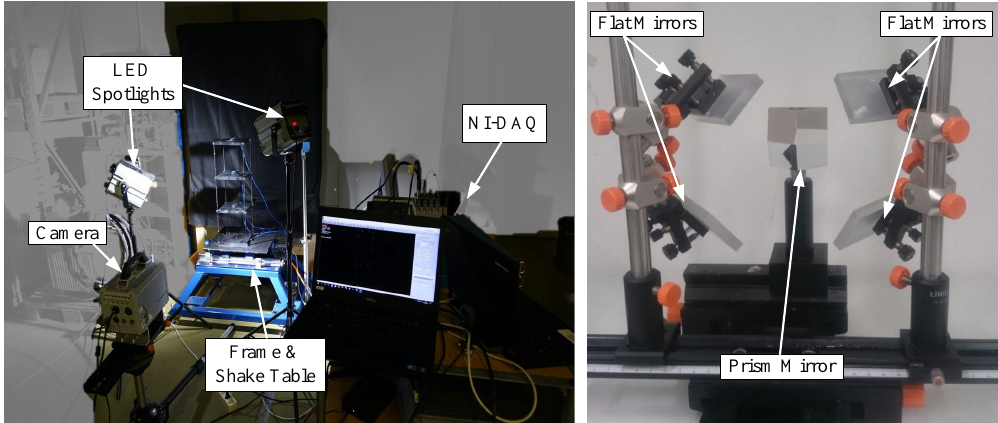
Figure 4. View of the experimental setup including the frame, shake table for triggering the motion, camera for recording the motion of the markers on the structure, LED spotlights for illuminating the investigation domain ( left ) and optical setup including image splitter and mirrors ( right ).